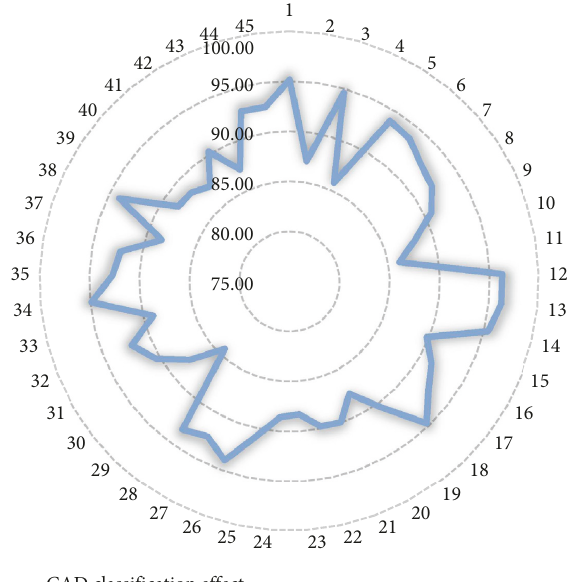
Figure 14: The statistical diagram of the classification effect of the 3D CAD model based on the knowledge recognition algorithm of convolutional neural